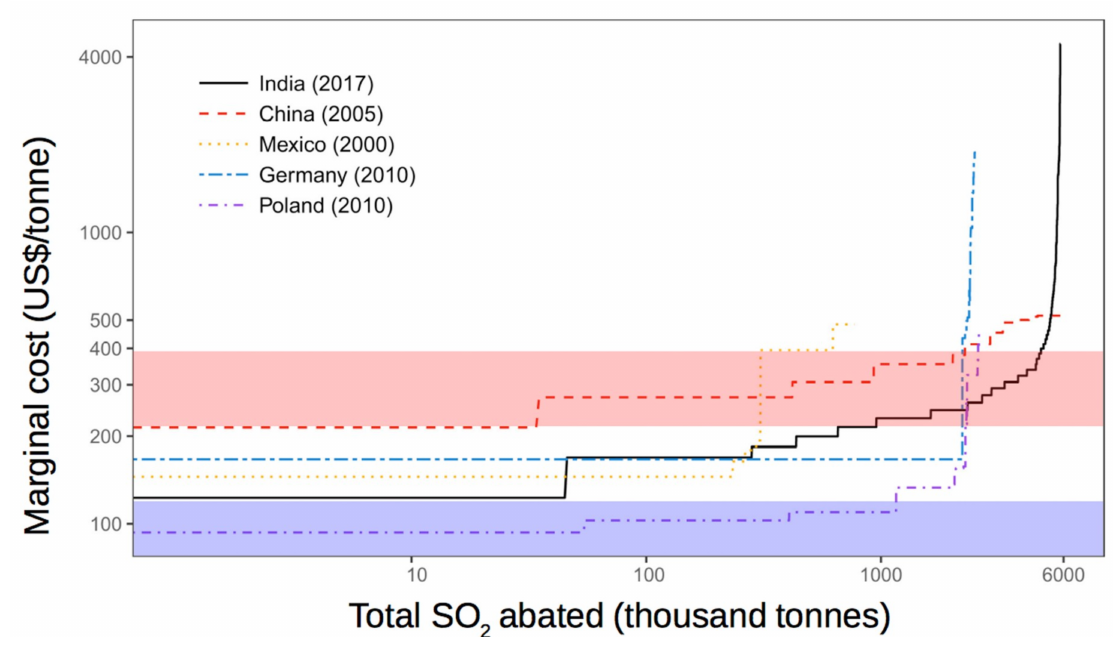
Figure 6. Marginal Cost Curve for SO 2 abatement from coal-fired power plants in India (solid black curve) and various other countries [32]. The coloured bands represent the estimated marginal cost estimates on the agricultural and allied services (blue: 83–124 US$/tonne) and on the overall economy (red: 212–396 US$/tonne) for the May–September season taken from the linear fits presented in Table 7. The ranges shown are for the central estimates and do not include their uncertainties which are given in Table